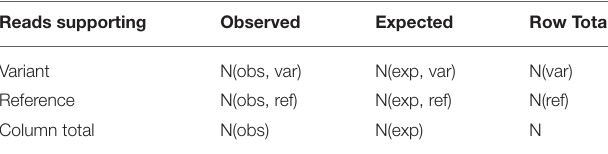
TABLE 4 | The 2 × 2 contingency table for computing p -value using Fisher exact test to predict somatic, germline and LOH